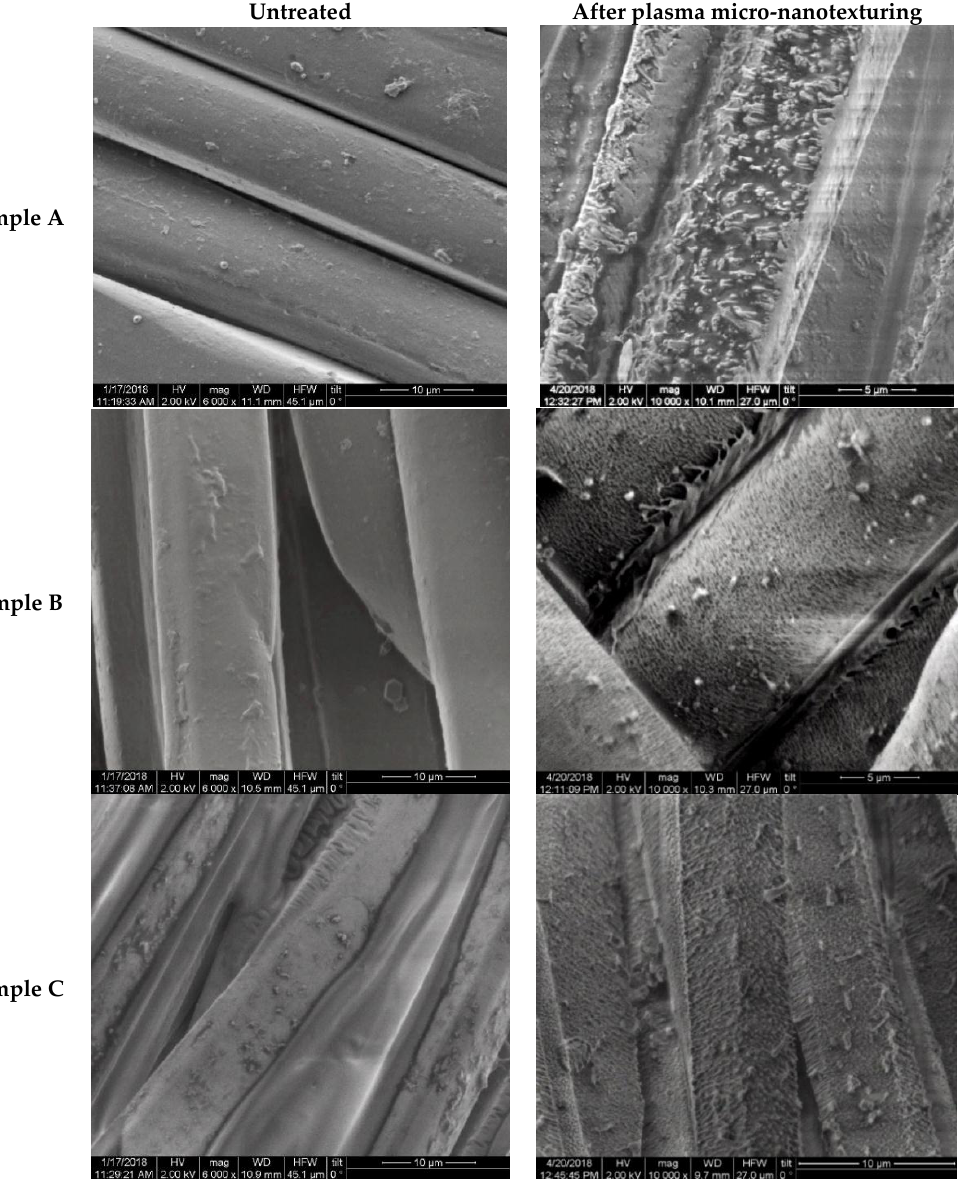
Figure 2. Top-down SEM images of the fabrics before and after the plasma micro-nanotexturing.